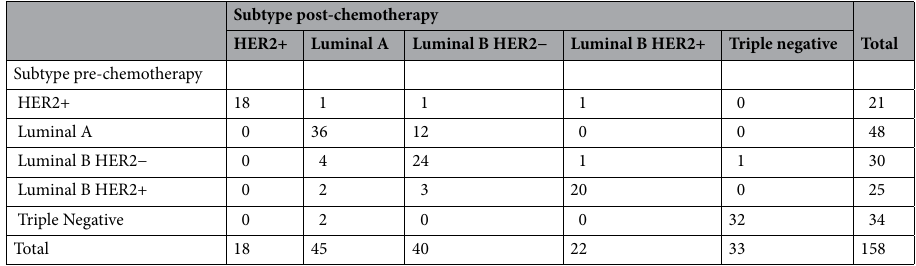
Table 6. Changes in intrinsic subtype after neoadjuvant chemotherapy. Differences between pre- and post- chemotherapy assessments were not statistically significant.